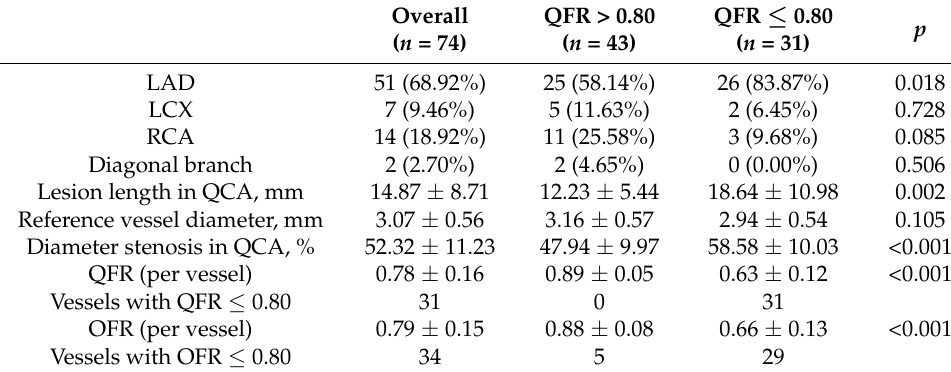
Table 2. Vessel characteristics with QFR ≤ 0.80 or >0.80.